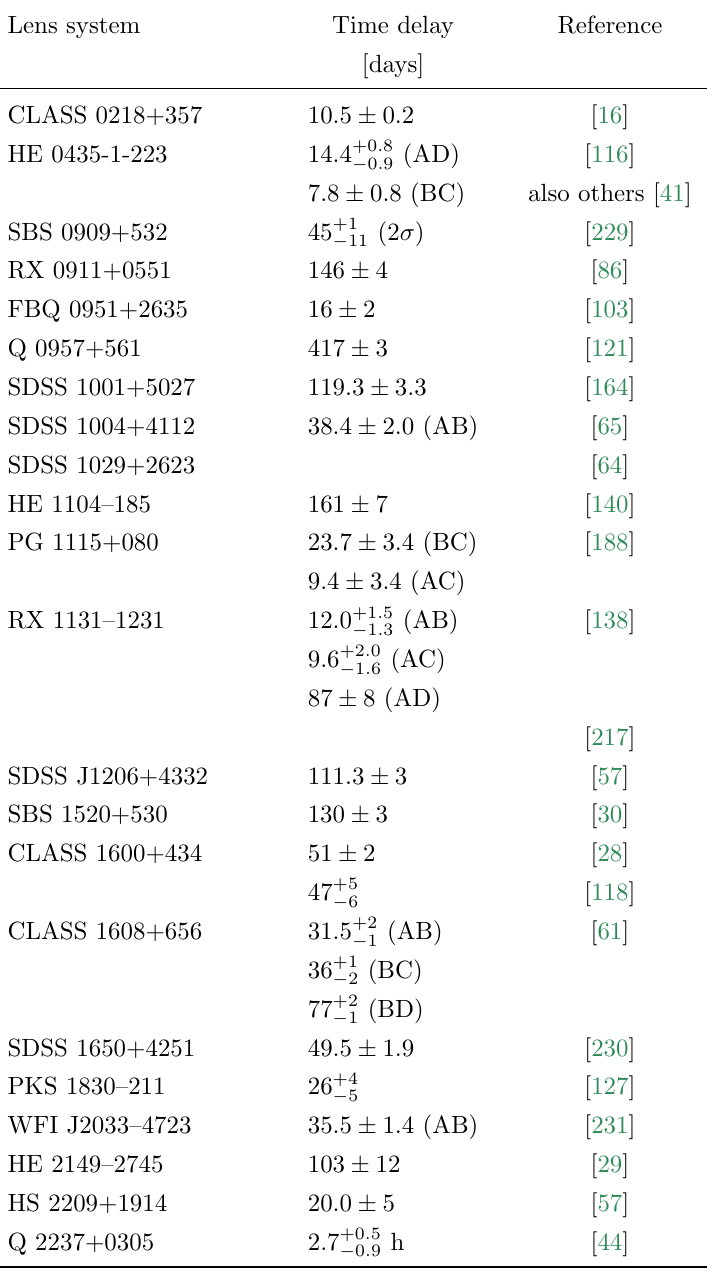
Table 1: Time delays, with 1- 𝜎 errors, from the literature. In some cases multiple delays have been measured in 4-image lens systems, and in this case each delay is given separately for the two components in brackets. An additional time delay for CLASS B1422+231 [151] probably requires verification, and a published time delay for Q0142–100 [120, 146] has large errors. Time delays for the CLASS and PKS objects have been obtained using radio interferometers, and the remainder using optical